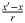
a) Deviation in x- and y-direction. Depicted are the deviation in the respective direction divided by the radius, i.e. x′-xr. Each blue dot represents a CS annotation AC of the Citizen Science Primer-experiment CSP. Please note that five outliers are not depicted in favor of a more detailed visualization. The red cross is just for orientation and depicts no deviation at all. b) Overlap displays the overlap of the expert annotation with the CS annotation. Relative radius r′r is the ratio of the radius r′ of the CS annotation and the radius r of the expert annotation. c) and d) show the same information on the same scale as a) and b) respectively but are protocol-corrected (see section Results for more details). e) and f) show the results for the Citizen Science Study CSS. Each dot represents a CS annotation AC of the CSS..